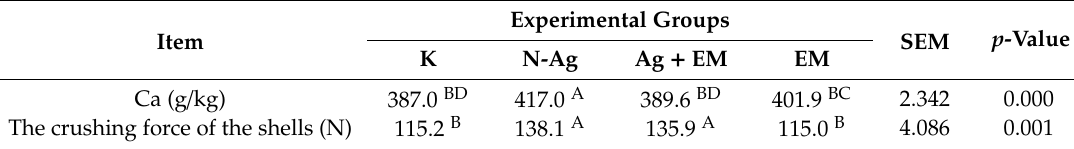
Table 5. The share of calcium and hardness of Cornu aspersum (Müller) snail shells in the control and experimental groups.